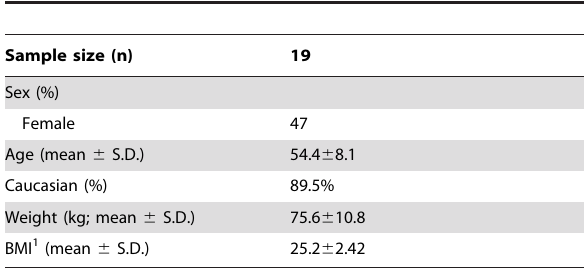
Table 1. Demographic characteristics of healthy control